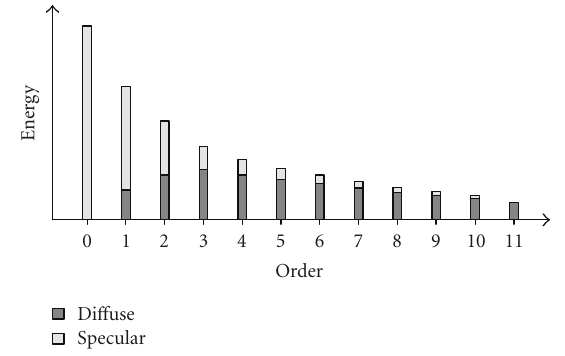
Figure 2: Conversion of specularly into di ff usely reflected sound energy, illustrated by an example (after Kuttru ff